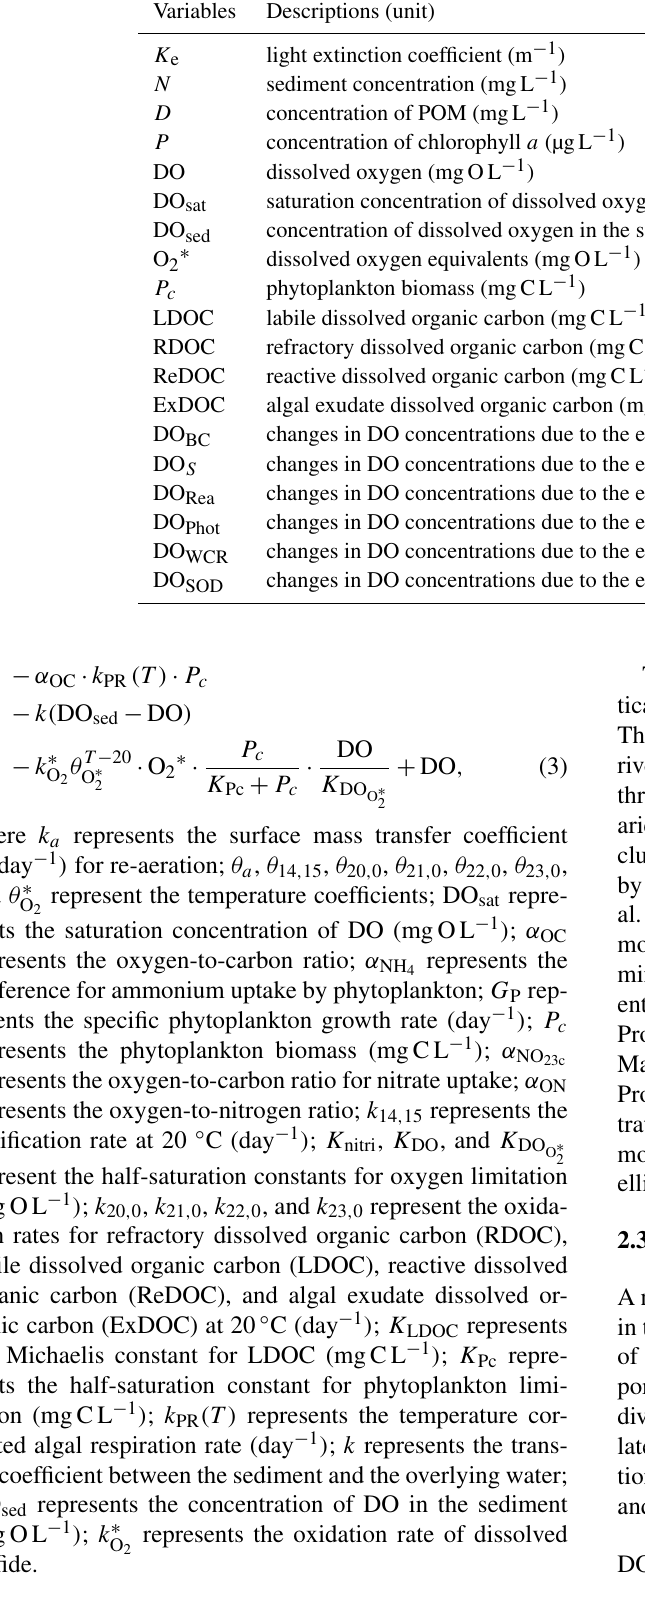
Table 1. List of state variables in the water quality model (RCA) and the physical modulation method